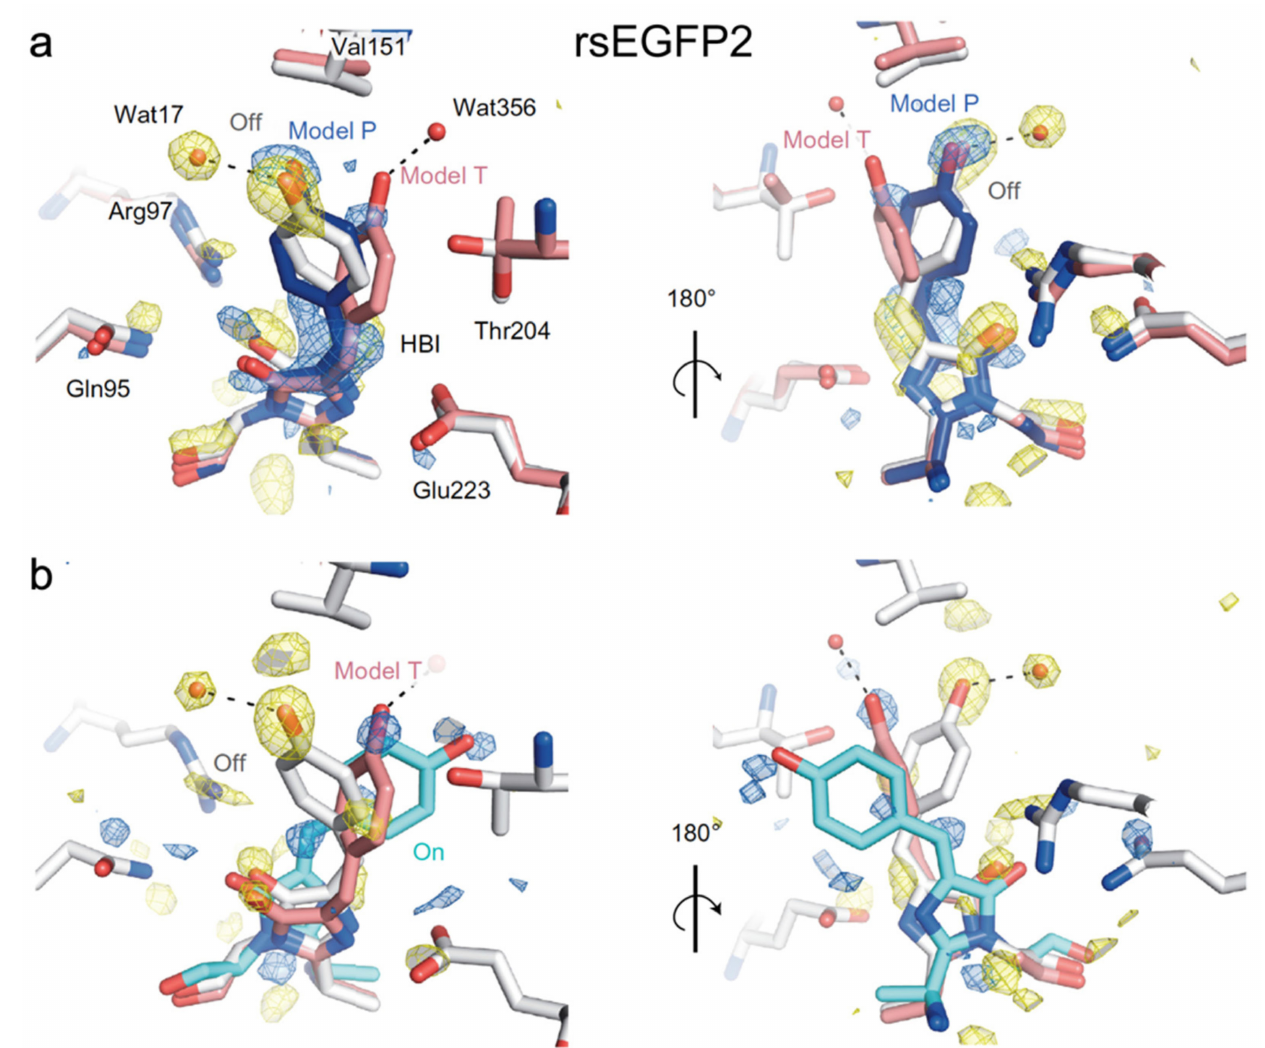
Figure 6. Local structure of rsEGFP2 in the first singlet electronic excited state modeled from difference Fourier electron-density maps of SFX data. ( a ) Comparison of Model P (blue), Model T (pink), and the off state (gray) against SFX map at 1 ps after photoexcitation (PDB ID: 5O8B) [45]. ( b ) Comparison of Model T (red) with the off (gray) and on (cyan; PDB ID: 5O89) states against SFX map at 3 ps after photoexcitation. Note that in model T, the twisted chromophore features perpendicular phenol and imidazolinone rings. Key surrounding residues are shown with the H- bond denoted by dashed lines. Reprinted with permission from Ref. [45]. Copyright 2017 Macmillan Publishers Limited, part of Springer